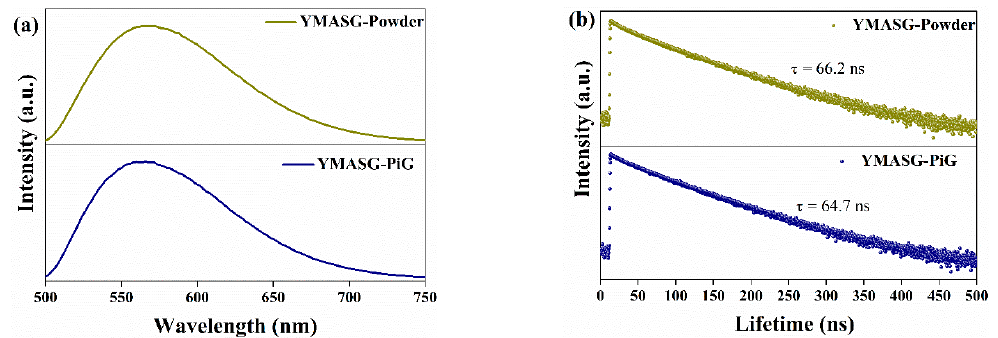
Figure 6. ( a ) The PL spectra of YMASG:0.05Ce 3+ and YMASG:0.05Ce 3+ PiG composite under 455 nm light excitation. ( b ) Decay curves of YMASG:0.05Ce 3+ and YMASG:0.05Ce 3+ PiG composite.